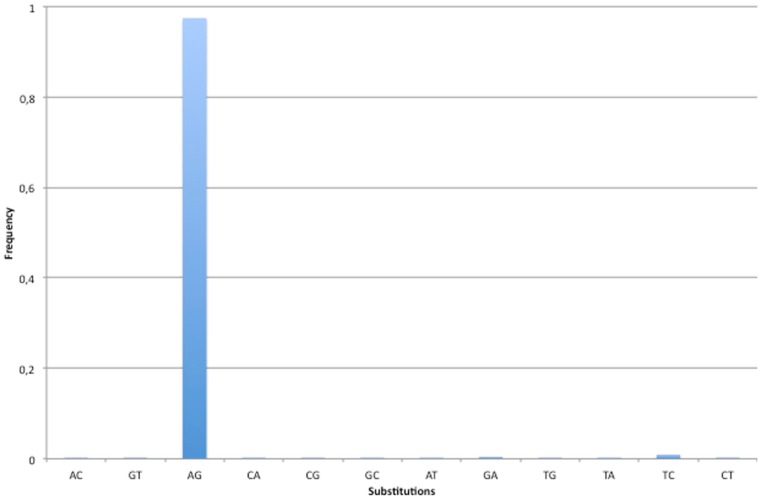
Base substitutions observed in human lncRNAs. The specificity of our methodology has been valuated looking at base substitutions in the set of predicted RNA editing events. Since A-to-I is the most frequent RNA editing event in human and I is commonly interpreted as G by cellular molecular machineries, the A-to-G change is expected to be the prominent substitution. As shown in figure, 97% of base changes in the predicted set of RNA editing events are A-to-G substitutions. All other changes have substitution frequencies lower than 1%.